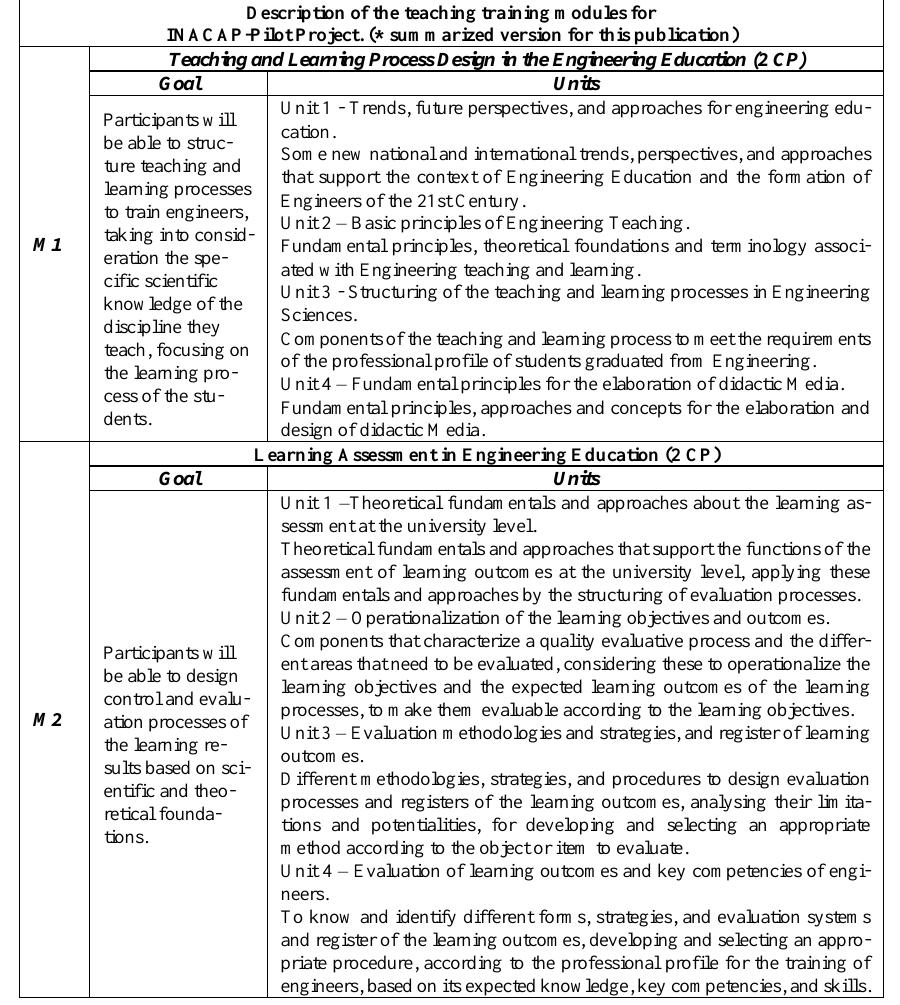
Table 1. Description of the teaching training course modules for INACAP-Pilot